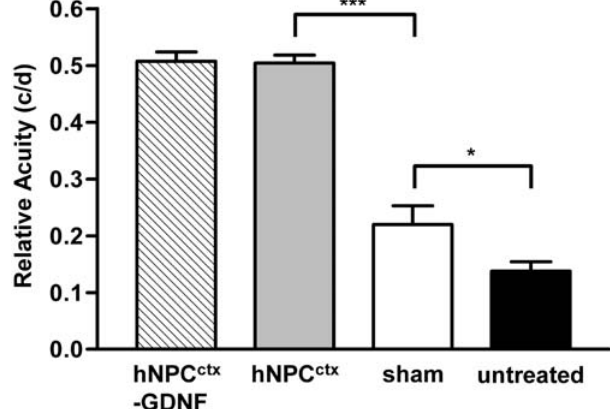
Figure 3. Spatial visual acuity is preserved in eyes receiving human neural progenitor cell grafts. Rapid, non-invasive measurements of spatial visual acuity thresholds were obtained using the OptoMotry head tracking apparatus. At approximately P100, eyes receiving subretinal hNPC ctx - GDNF ( n =11) or hNPC ctx ( n =21) demonstrated superior spatial visual acuity compared to sham-injected eyes ( n =4; *** p , 0.001), with best- grafted animals yielding near-normal responses (0.6 c/d). Spatial visual acuity was also significantly better in sham-treated vs. untreated ( n =29; * p , 0.05) eyes, reflecting the known ‘‘sham effect.’’ Statistical signifi- cance was determined via one-way ANOVA with the Newman-Keuls procedure for multiple comparison analysis.